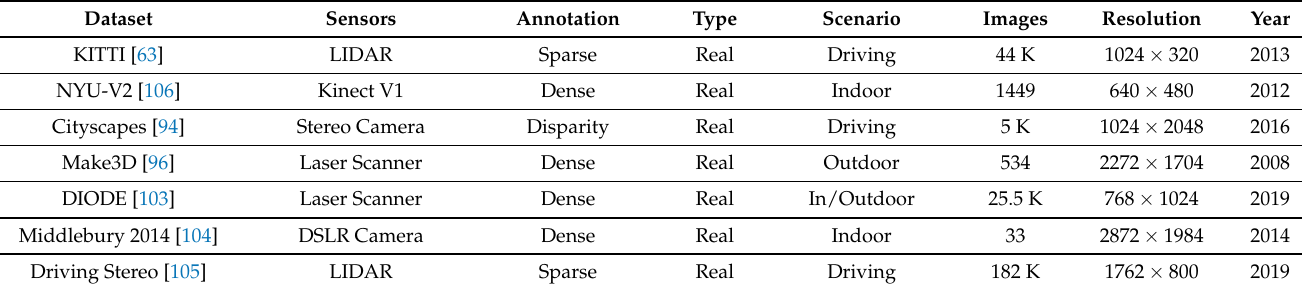
Table 5. A summary of depth estimation public